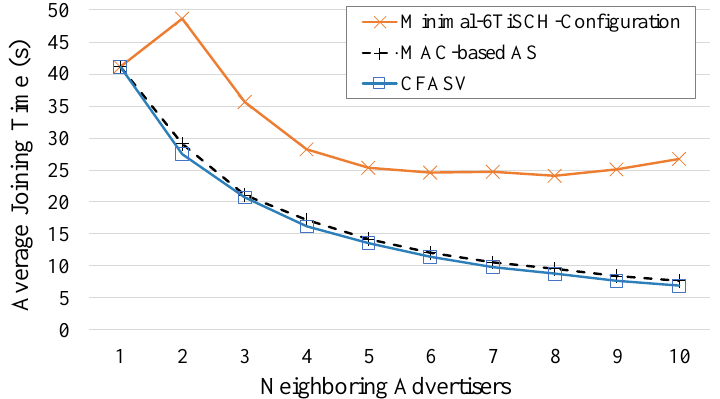
Figure 13. Comparison between CFASV, its MAC-based alternative and the minimal 6TiSCH configuration for a fixed joining